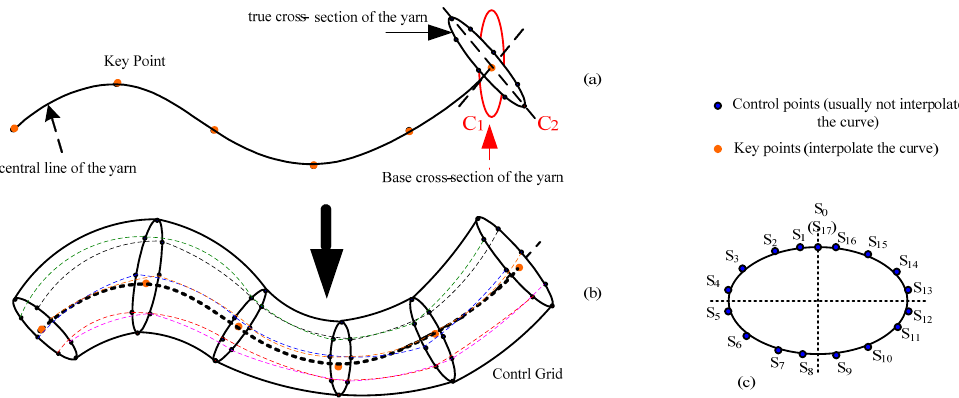
Figure 2. Principle of designing a 3D slub yarn. ( a ) Schematic diagram of the central curve and base cross-section of a 3D yarn. ( b ) The control grid for a 3D yarn modelled by B-spline curve. ( c ) Key control points for the cross-section of a 3D yarn.